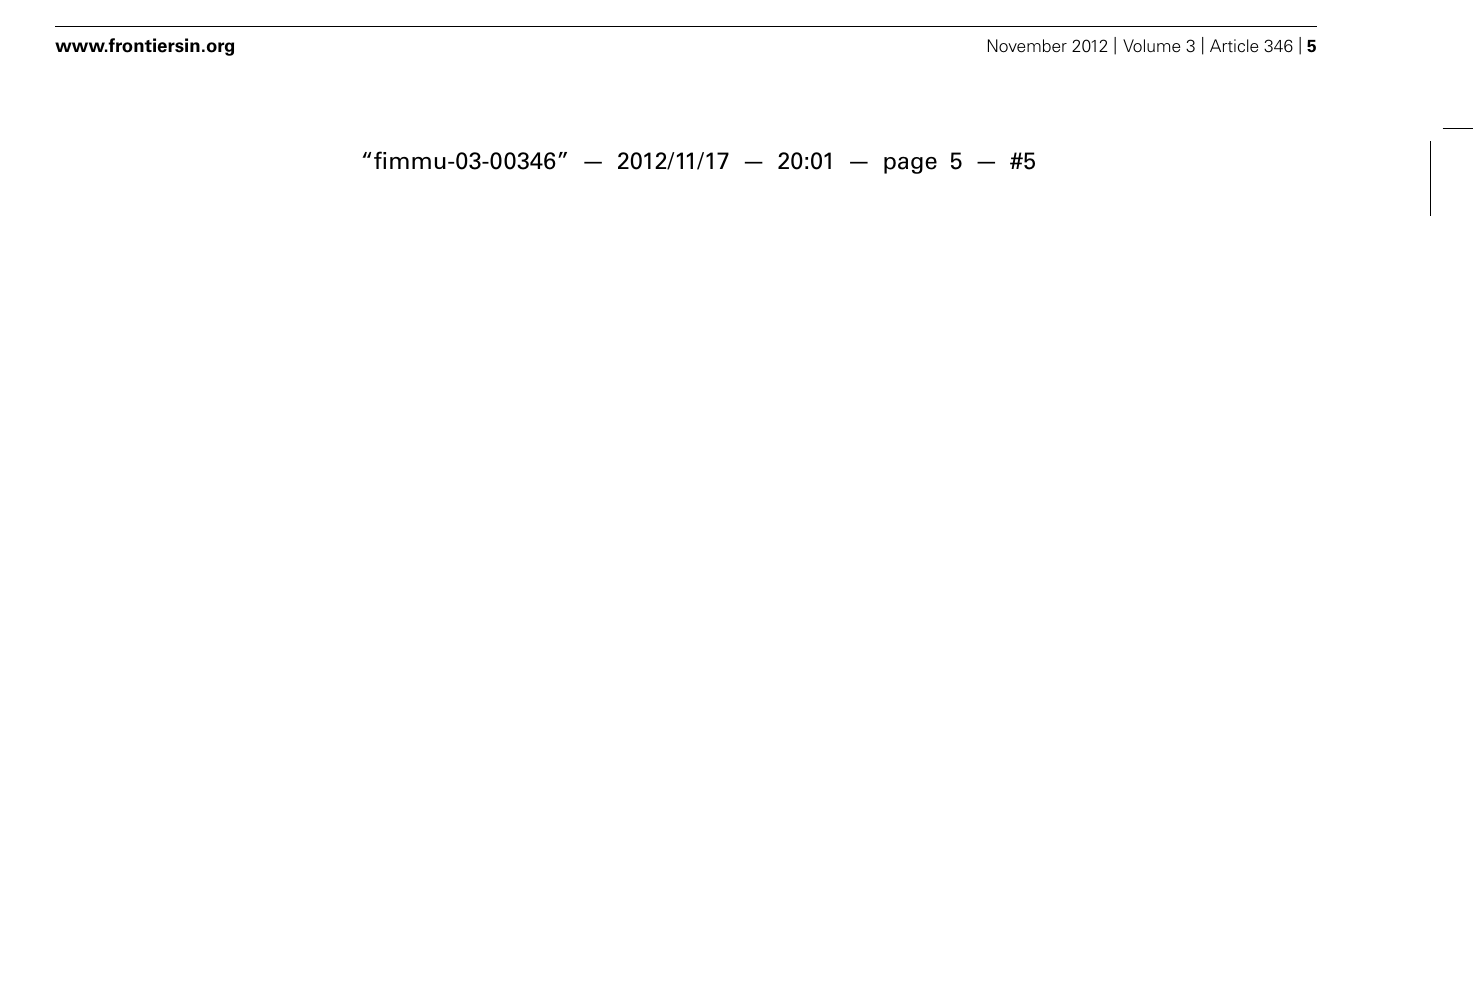
FIGURE 2 | Chemokine receptor expression of CD161 + CD4 + T cells in healthy donor blood. Healthy donor blood was stained as described in methods and analyzed for expression of the following chemokine receptors: